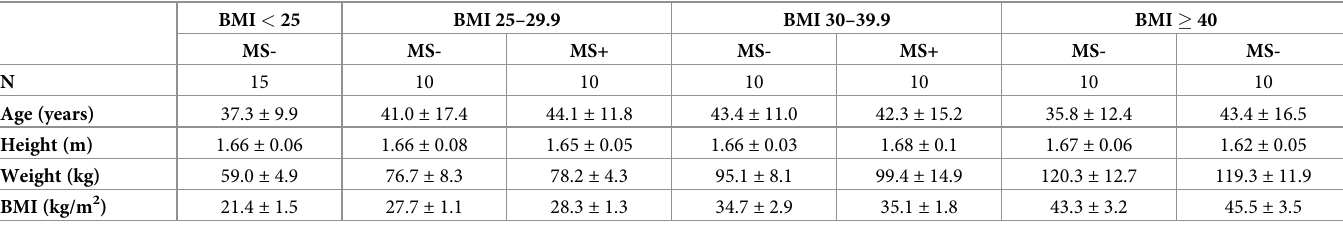
Table 1. Patient characteristics of study cohort 1.